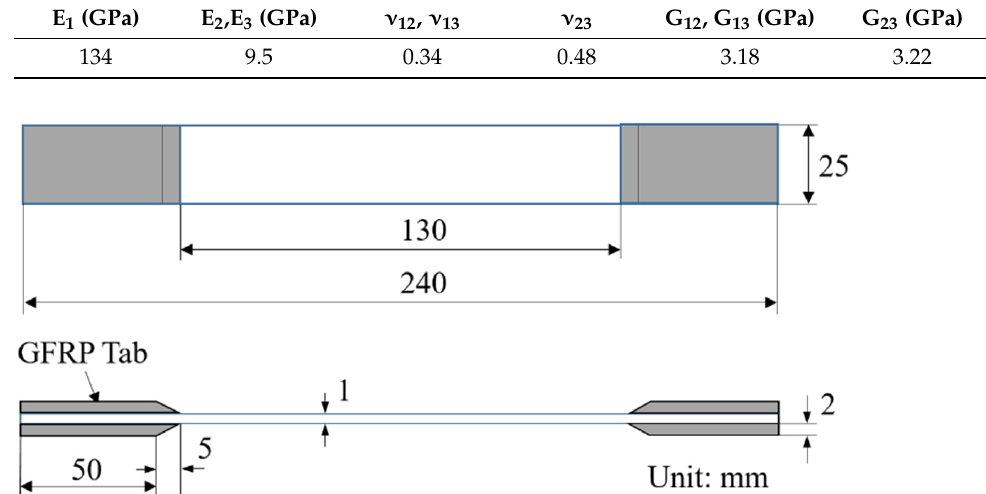
Table 1. Stiffness constants of UD lamina.